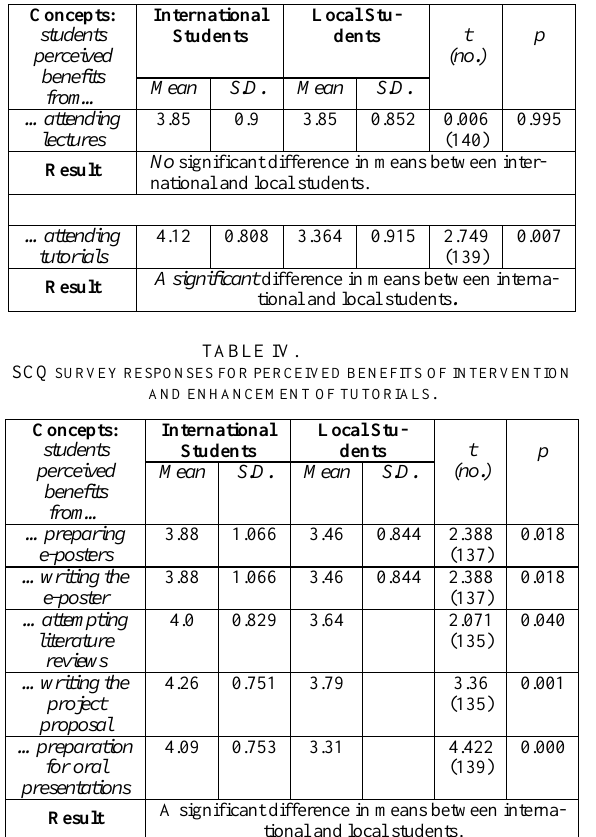
TABLE III. SCQ SURVEY RESPONSES FOR PERCEIVED BENEFITS OF ATTENDING LECTURES AND TUTORIALS .